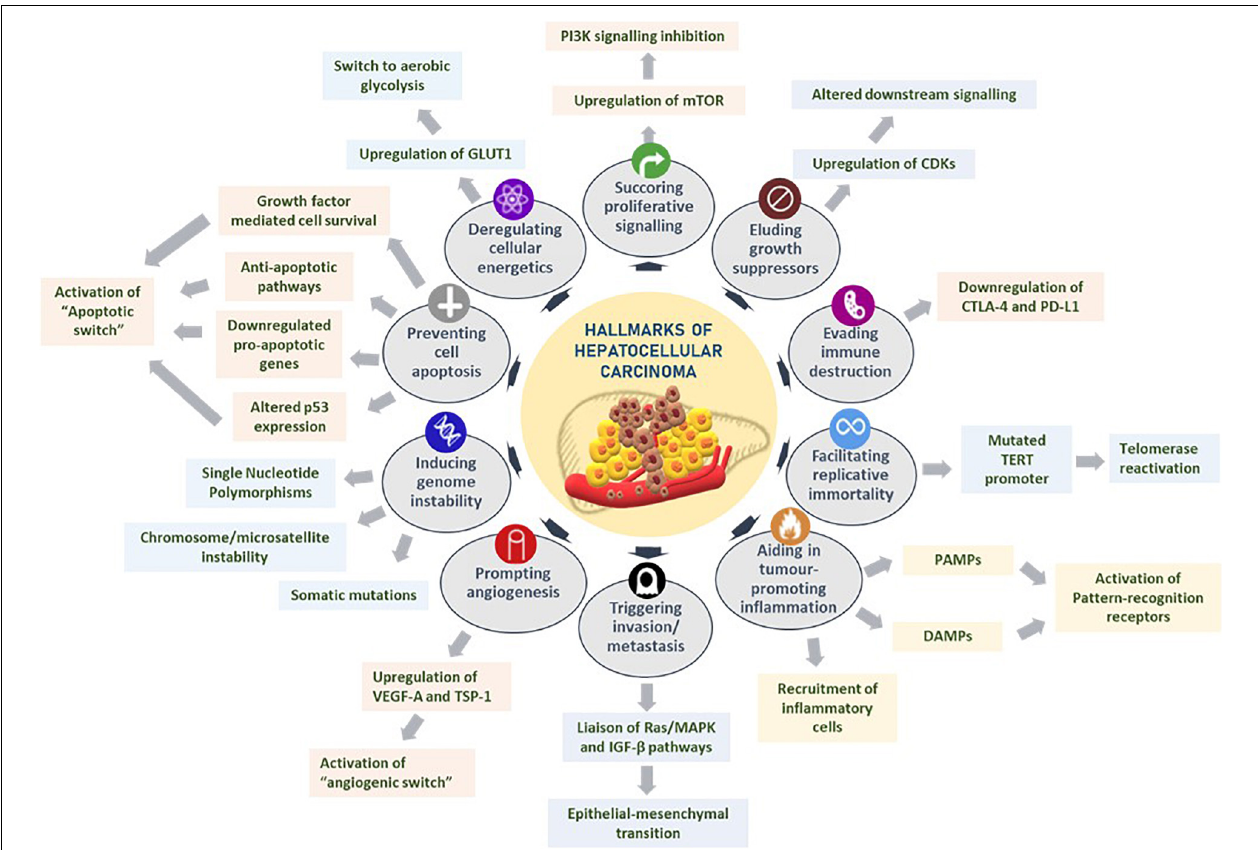
FIGURE 1 | Hallmarks of hepatocellular carcinoma. Several liver tumorigenesis-driving hallmarks affect the downstream cellular mechanisms by sustaining proliferative signaling, eluding growth suppressors, evading immune destruction, facilitating replicative immortality, aiding in tumor-promoting inflammation, triggering invasion and metastasis, prompting angiogenesis, inducing genome instability, preventing cell apoptosis, and deregulating cellular energetics. Figure modified from Hanahan and Weinberg